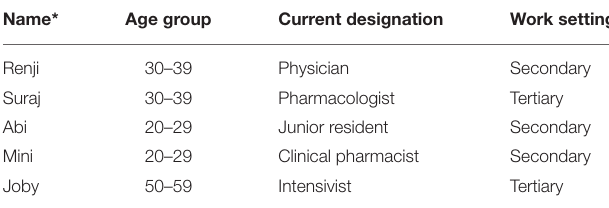
TABLE 3 | Basic profile of